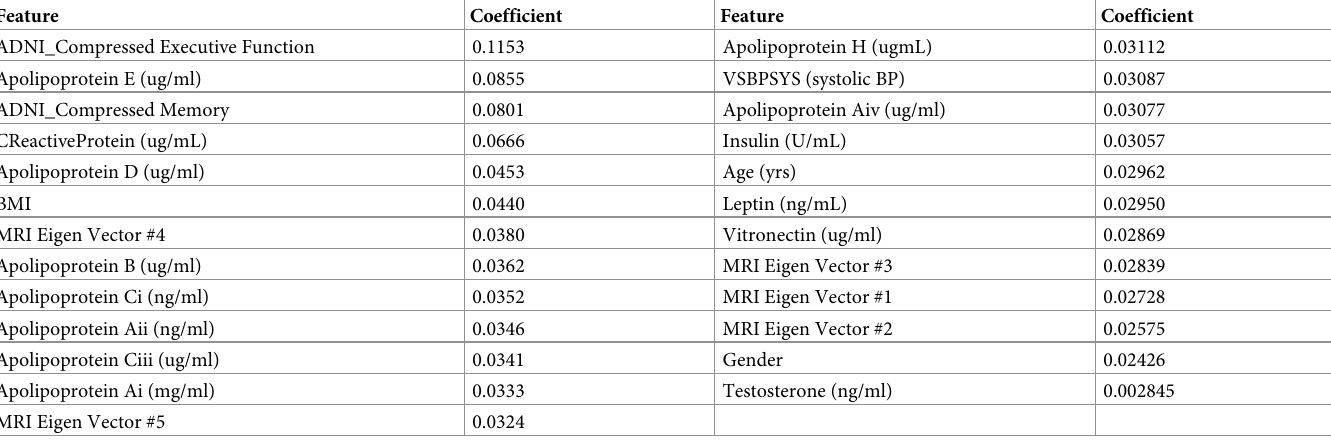
ther improved to 0.75 by combining both modalities). Table 2. GINI importance of features from MRI eigenvectors and plasma